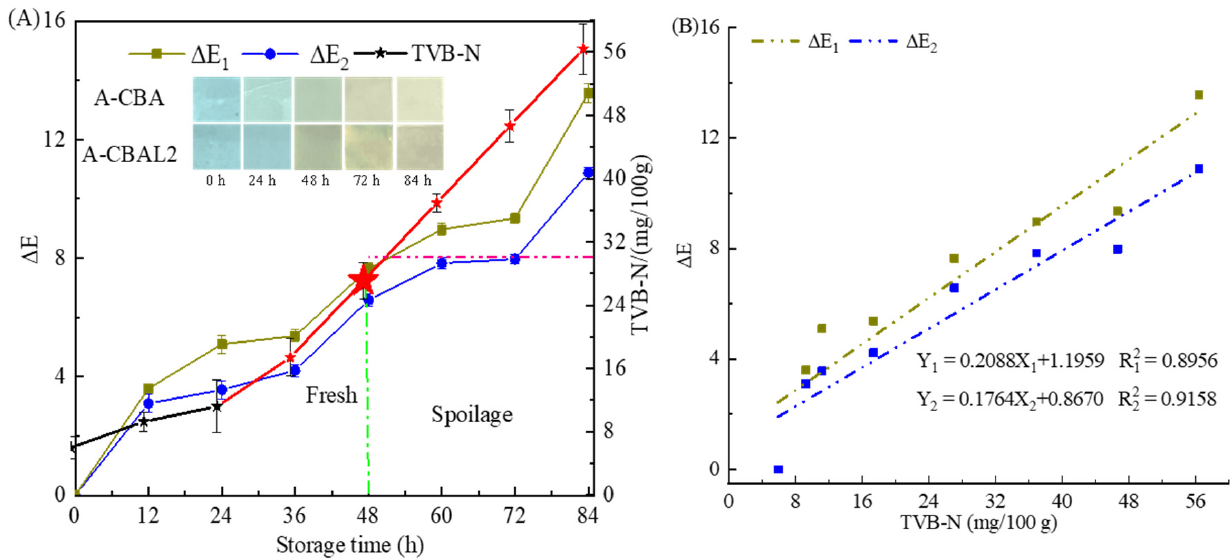
Figure 6. The TVB-N of shrimp and ∆ E of the films ( A ). ∆ E 1 is A-CBA and ∆ E 2 is A-CBAL2 at the storage time. Correlation relation between TVB-N and ∆ E ( B ). The illustration is the color change of films during storage.